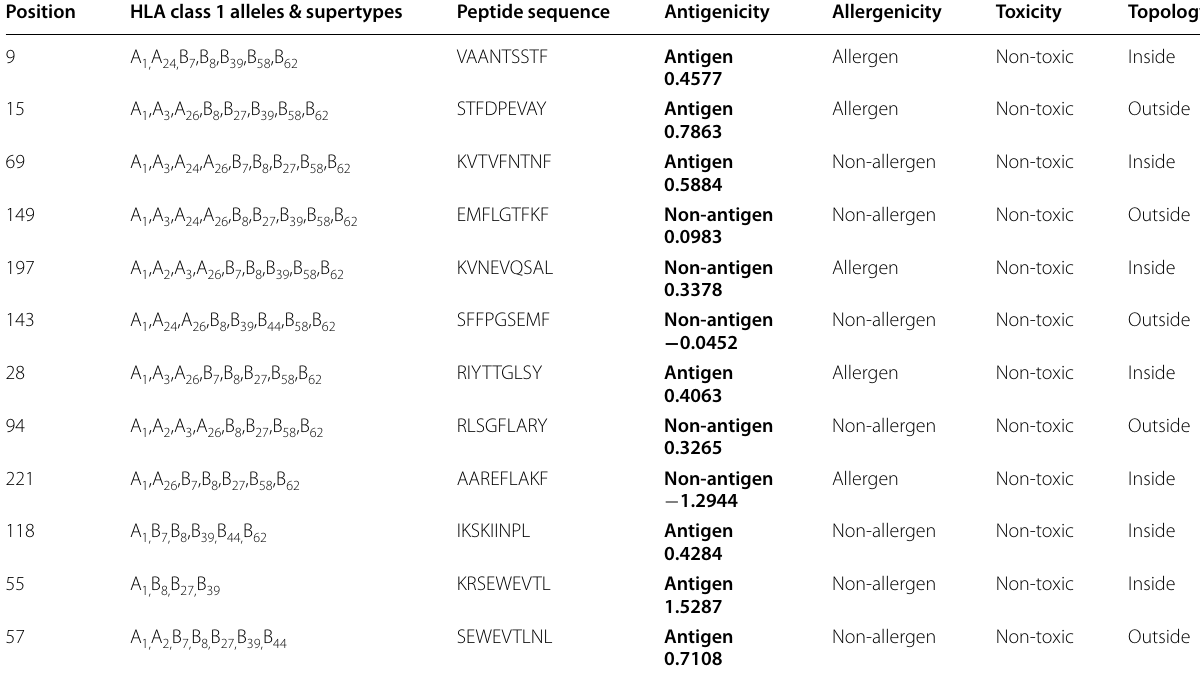
Table 2 MHC Class-I epitopes antigenicity, allergenicity, toxicity, and topology